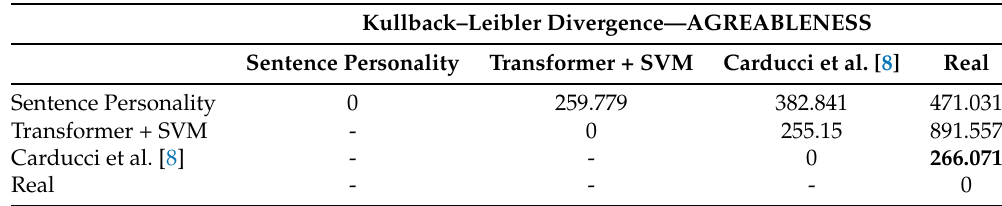
Table 7. Kullback–Leibler divergence computed among probability distributions on Agreeableness.